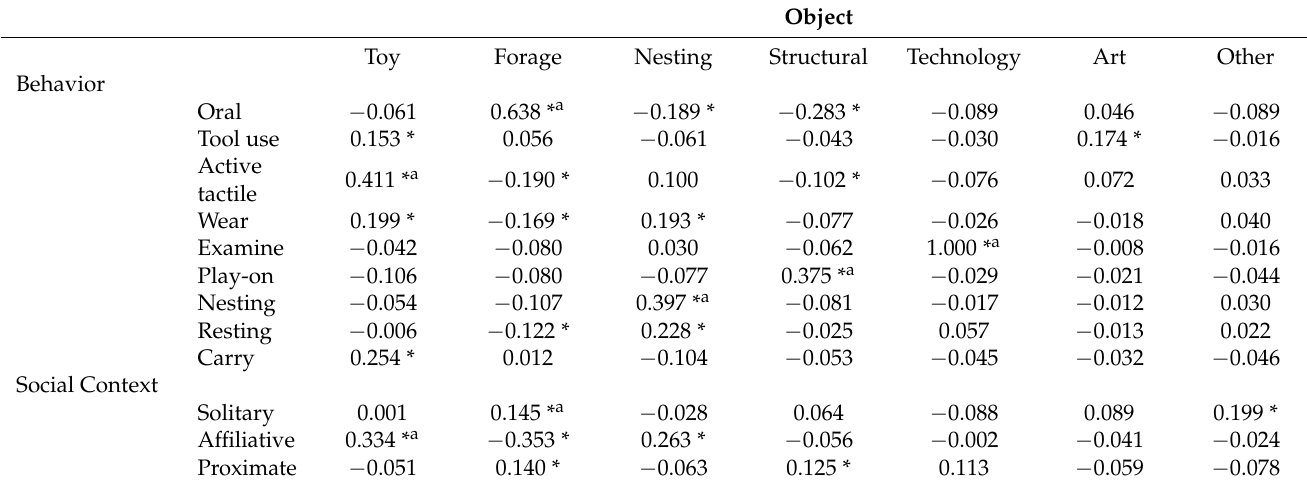
Table 7. Spearman’s rank correlation coefficient (Spearman’s rho) for objects, behaviors, and social contexts ( n = 760 occurrences of enrichment